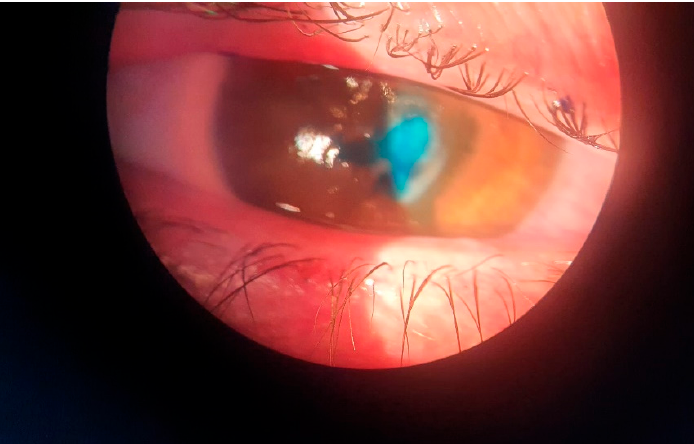
Figure 1. Slit-lamp examination of the right eye showing conjunctival hyperemia, a 4 mm white– yellow central corneal ulceration with infiltrated margins that retains the stain, Descemet folds at the lesion, and endothelial edema (methylene blue staining).